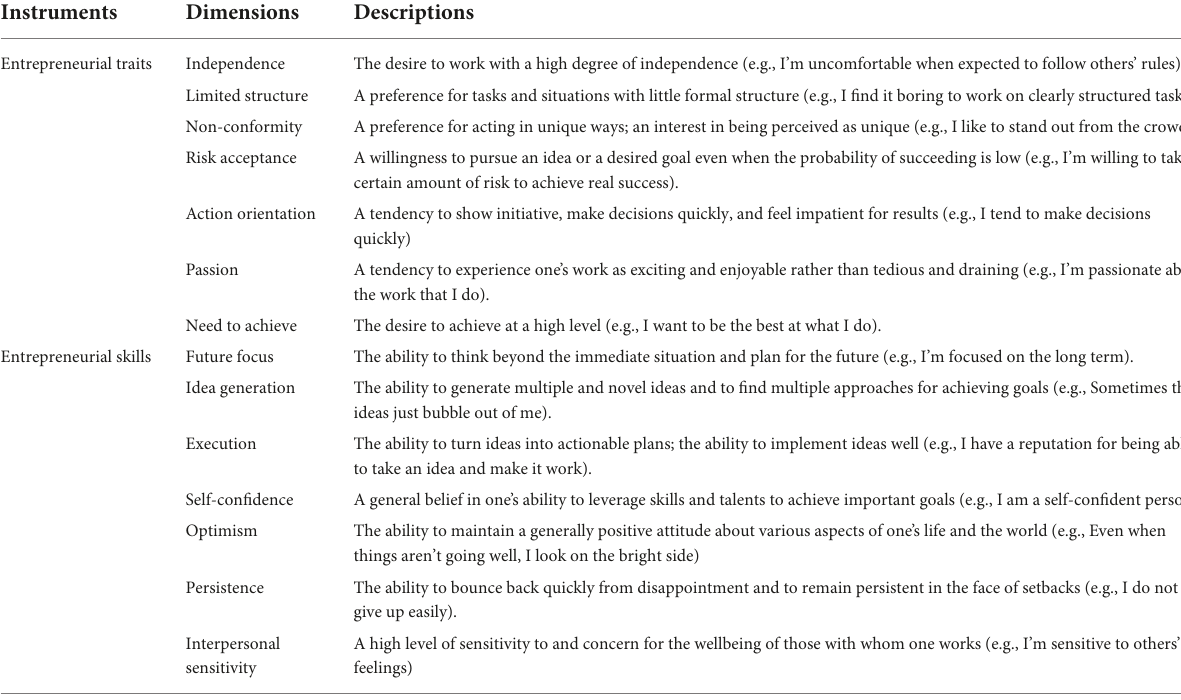
TABLE 2 Dimensions of entrepreneurial